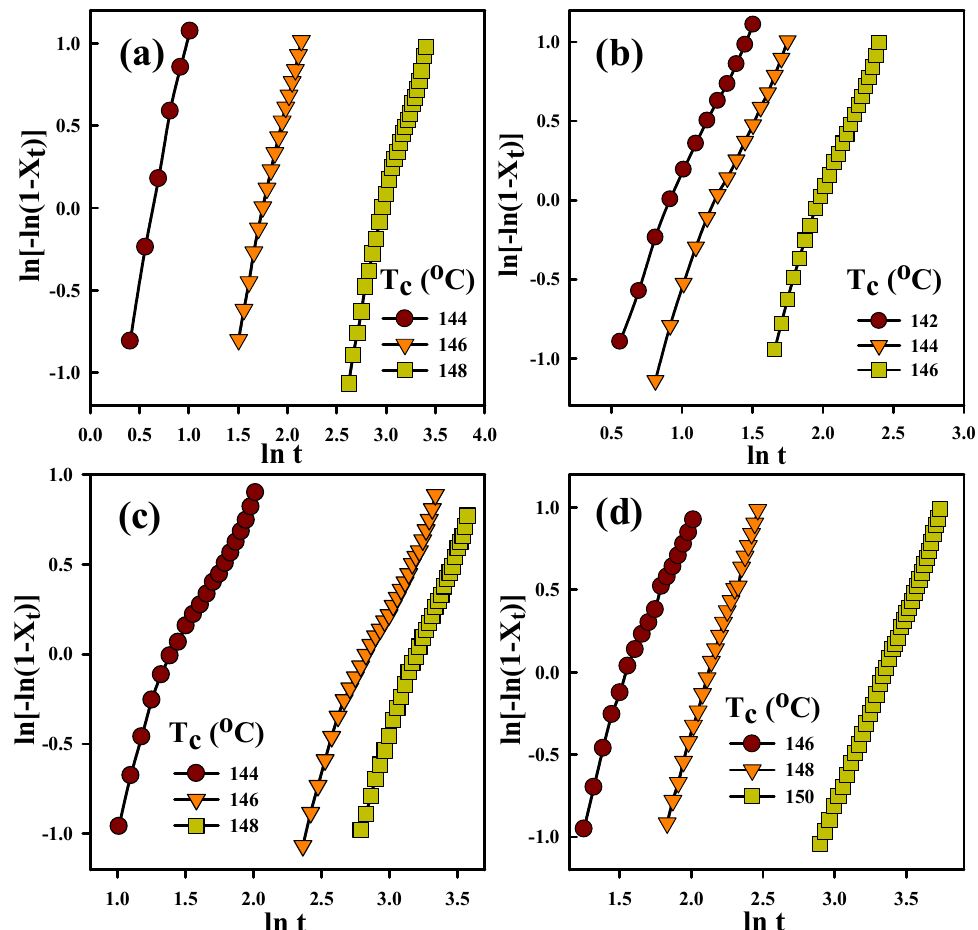
Figure 5. Avrami plots of PVDF isothermally crystallized at different T c s in different samples: ( a ) PVDF, ( b ) F7E3, ( c ) F7E3-1, and ( d ) F7E3-3.